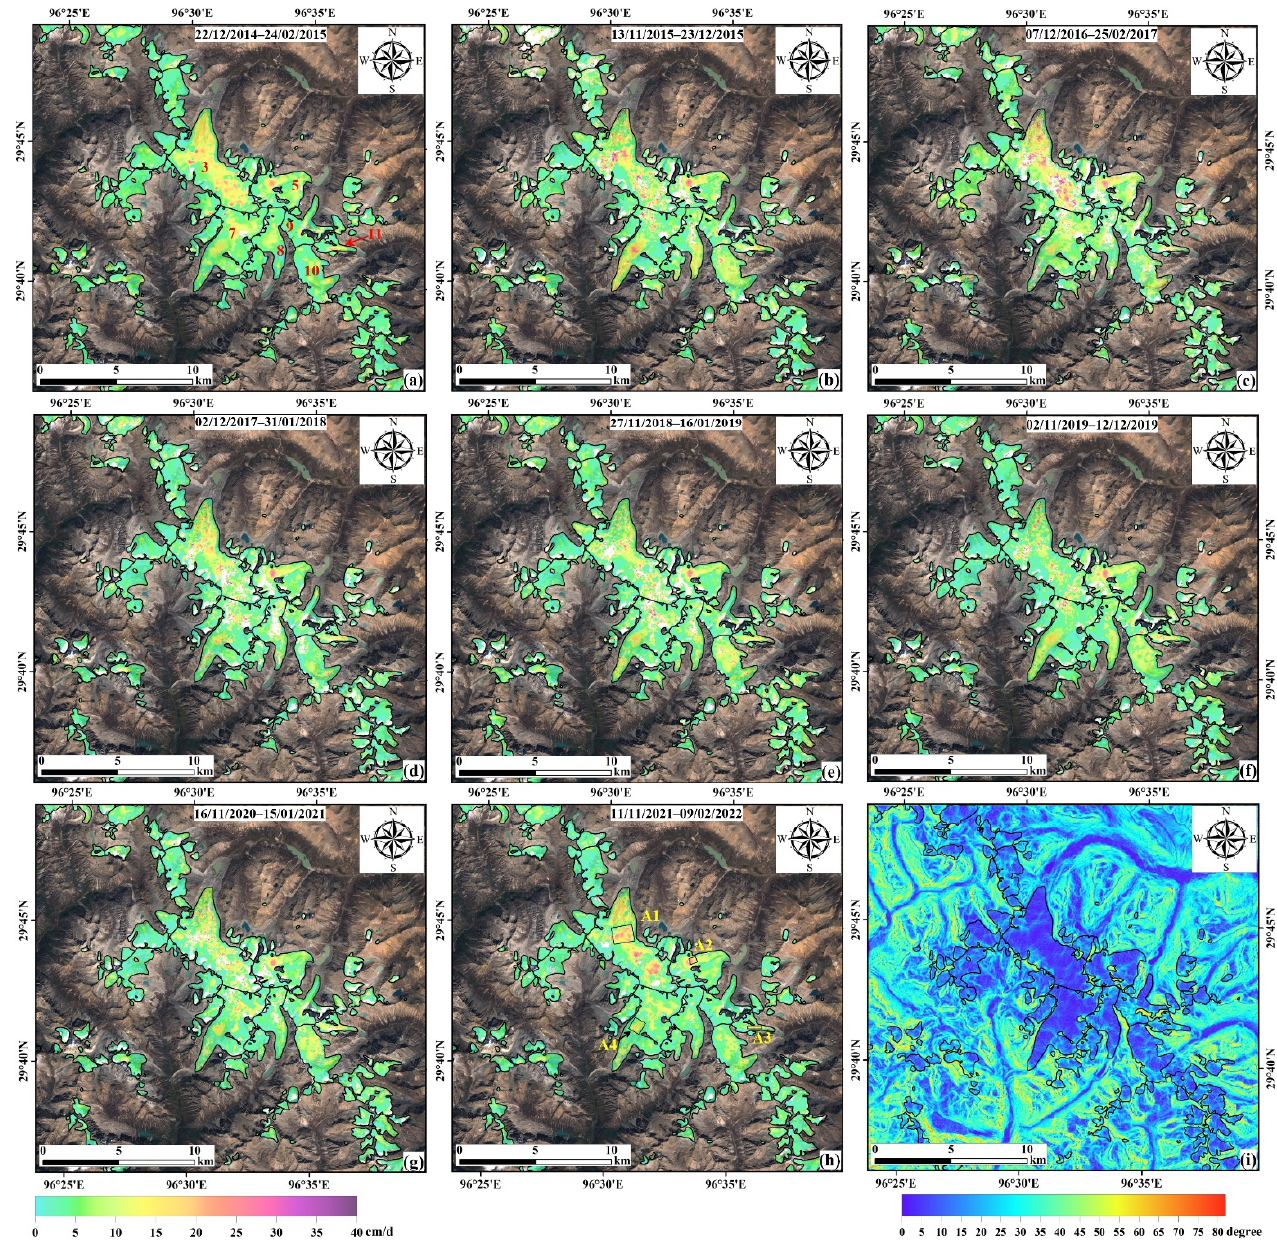
Figure 5. The derived two-dimensional glacier flow velocity during 2014–2021 ( a – h ), and the ground surface slope ( i ). The black curves are glacier boundaries. The red numbers in ( a ) mark the glaciers mentioned in the text. Rectangles A1–A4 in ( h ) mark the areas where glacier flow velocities in each observation period were averaged (see Table 3). The background of ( a – h ) is the Sentinel-2 image acquired on 12 October 2021. Table 3. Average winter glacier flow velocity in A1–A4 during 2014–2021 (cm/d).